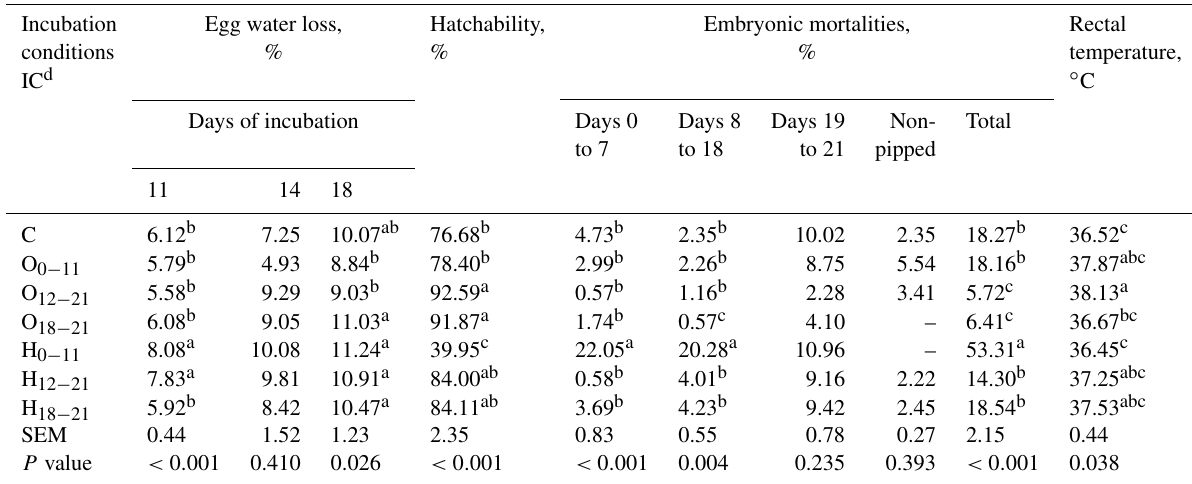
Table 3. Effects of incubation conditions on egg water loss of broilers on days 11, 14 and 18 of incubation, hatchability, embryonic mortali- ties, and rectal temperature induced by hypoxia at high altitude of chicks at hatching.